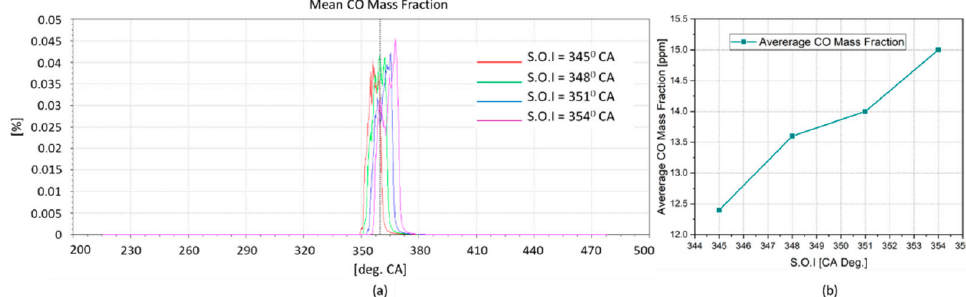
Figure 27. Mean CO mass fraction diagrams ( a ) and the average CO mass fraction ( b ) according to the change of the pilot S.O.I angle in the dual-fuel